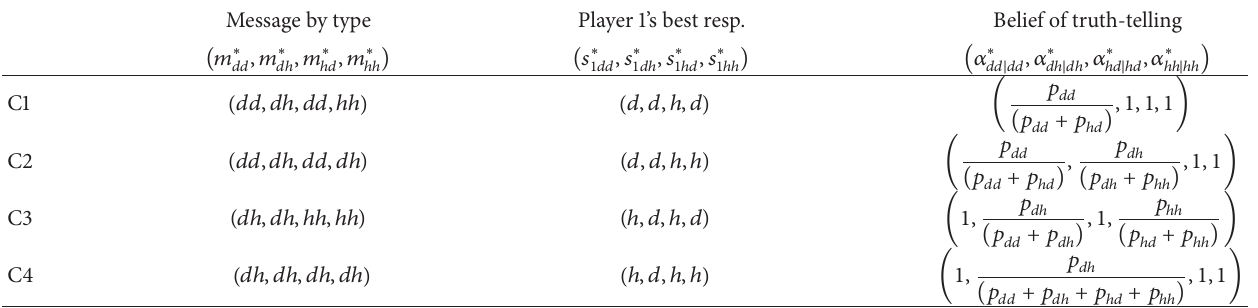
Table 6: Perfect Bayesian equilibria that satisfy Axioms 1 and 2. Message by type Player 1’s best resp. Belief of